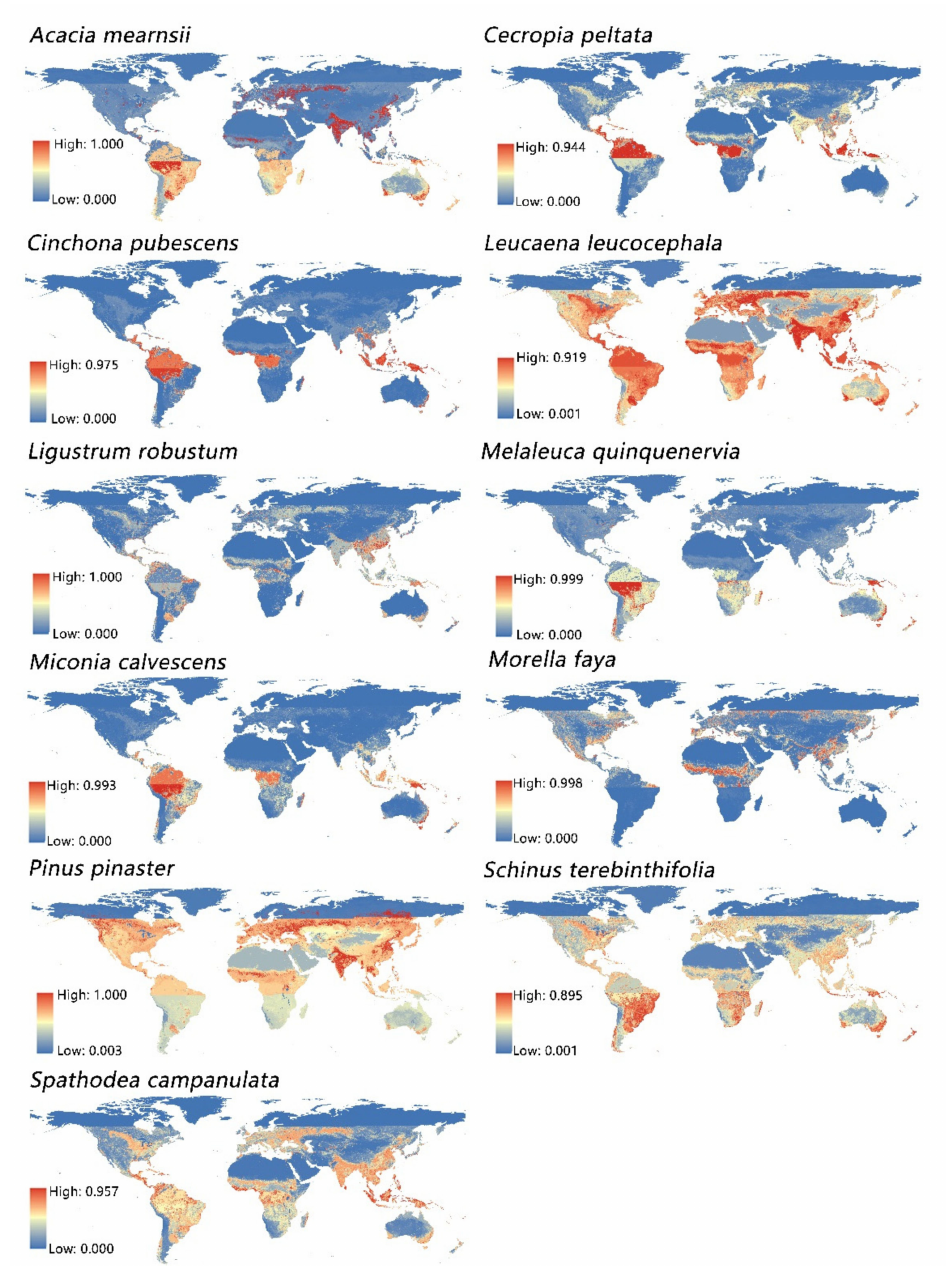
Figure 2. Hot spots of the probability distribution of 11 invasive tree species inferred to be influenced by the consensus land cover data. Red represents the high distribution probability of invasive tree species, and blue represents the low distribution probability of invasive tree species. The probability of distribution from blue to red increases